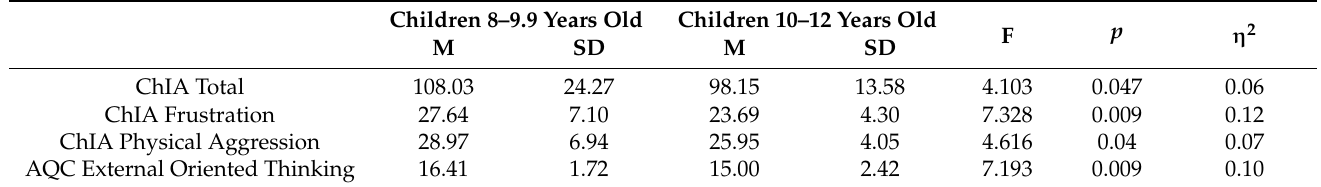
Table 3. Significant differences in psychological characteristics in children aged 8–9.9 vs.